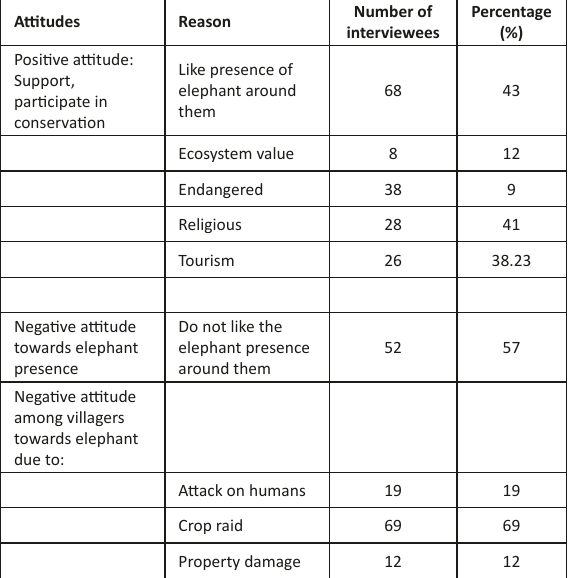
Table 1. Attitudes of local communities towards conservation of wild elephants (n=100) Attitudes